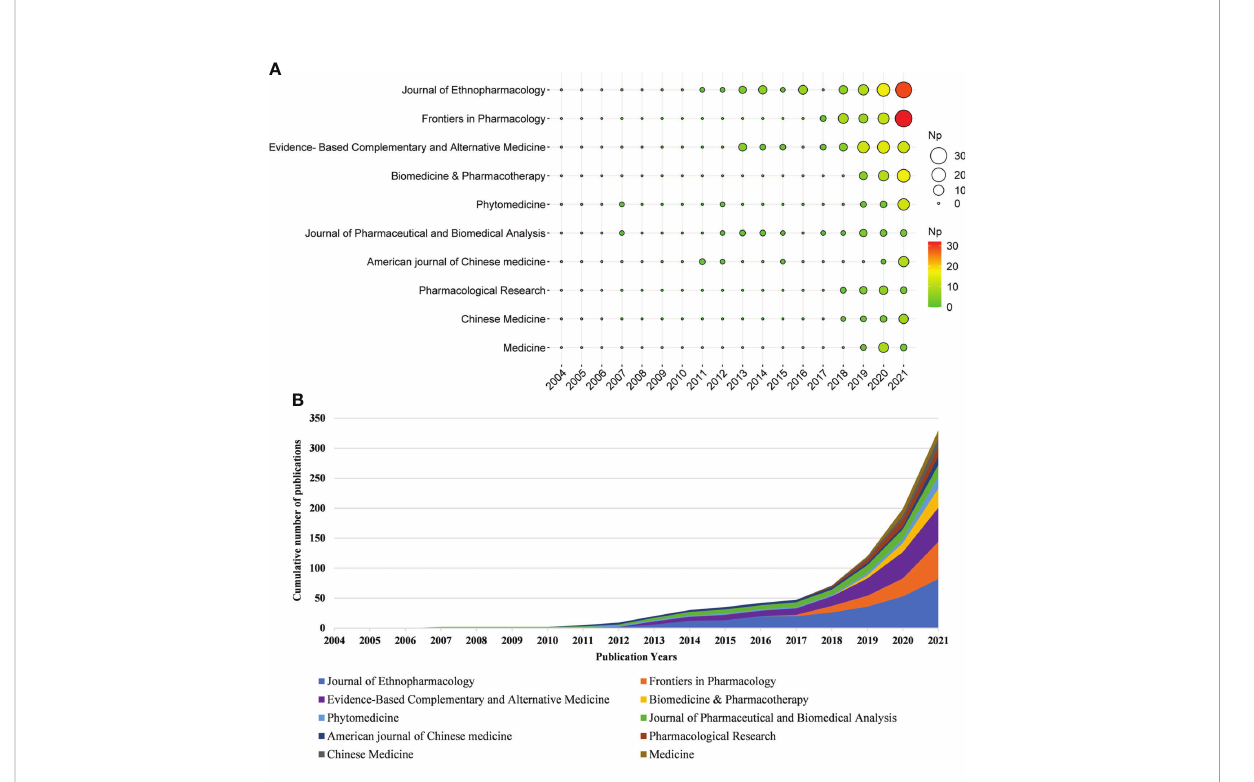
FIGURE 4 (A) The top 10 journals ’ annual publications over time in TCM/GM (the size of the circle represents the number of papers, and the larger the circle, the more the number of papers). (B) The cumulative number of papers of the top 10 journals in TCM/GM.